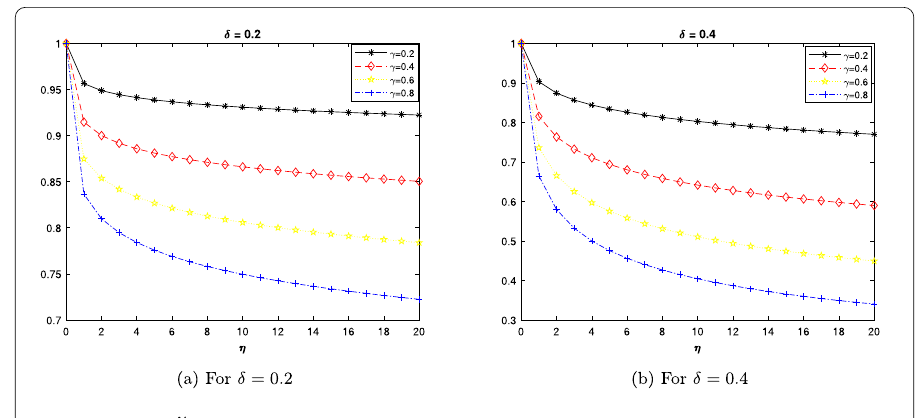
Figure 1 Plot of E γ